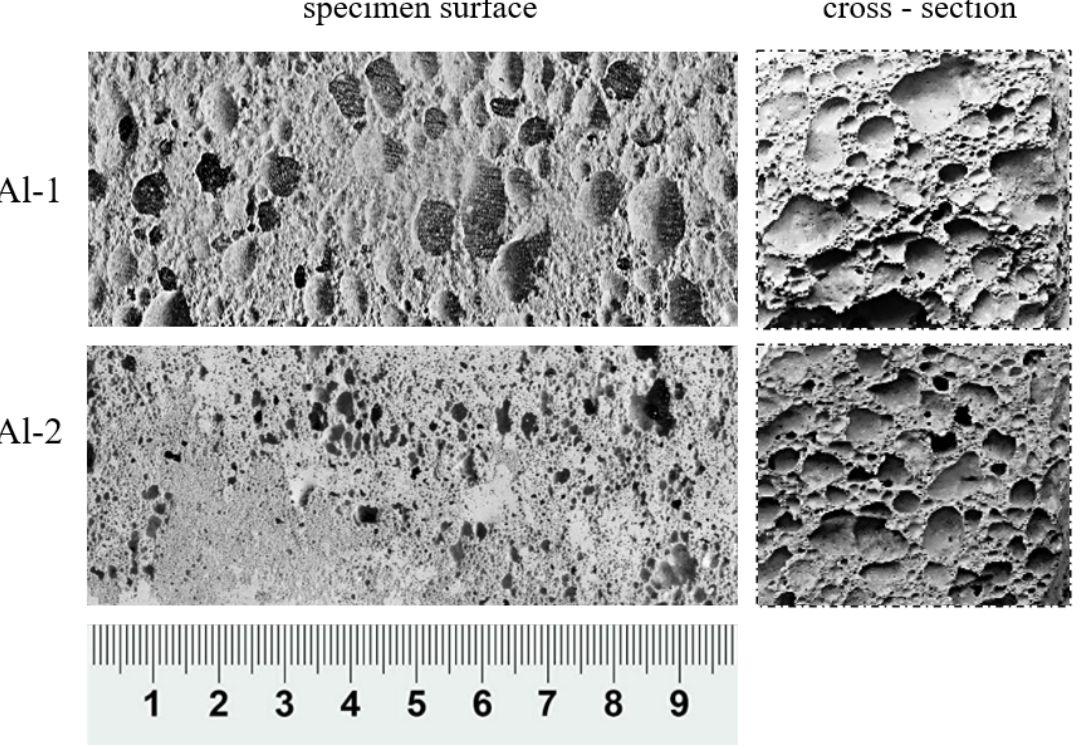
Figure 2. Surface and cross-section of the samples—porous structure and pores arrangement.